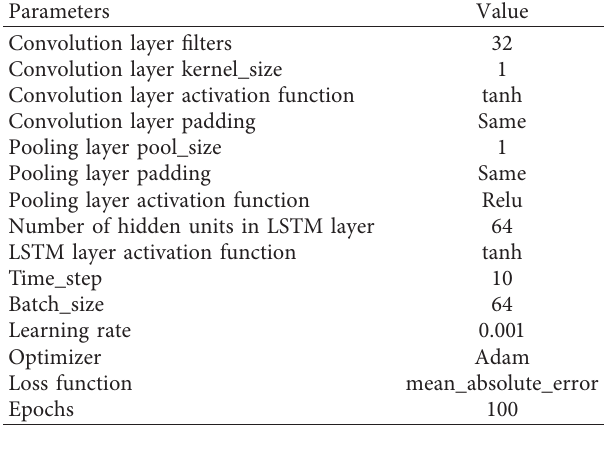
Table 2: Parameter setting of CNN-LSTM.